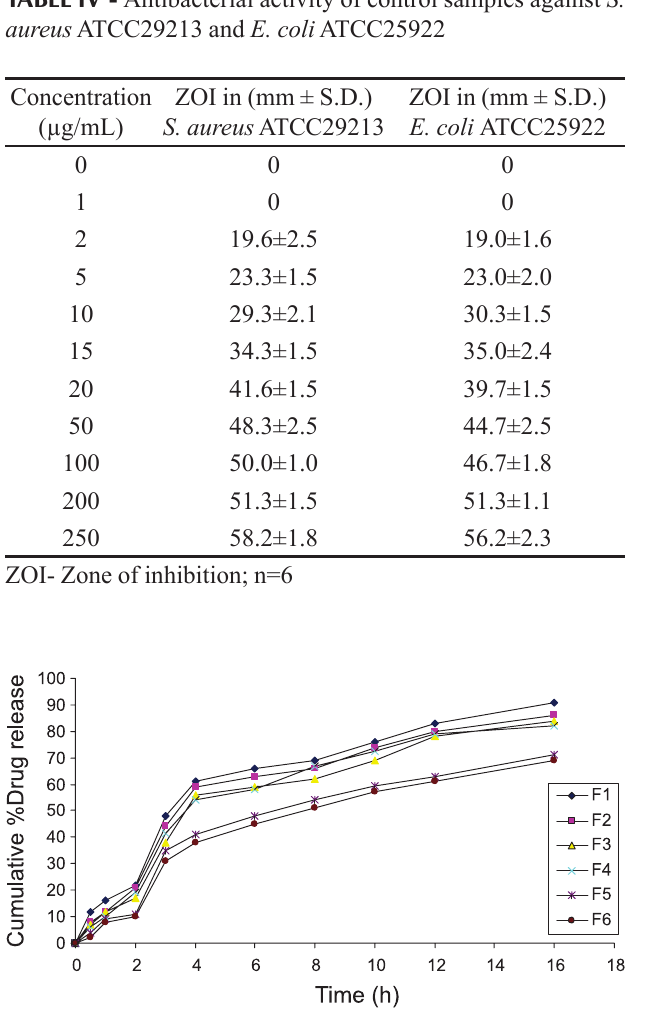
FIGURE 1 - In vitro drug release profile of time-dependent release bilayer tablet containing AMT by dissolution study.